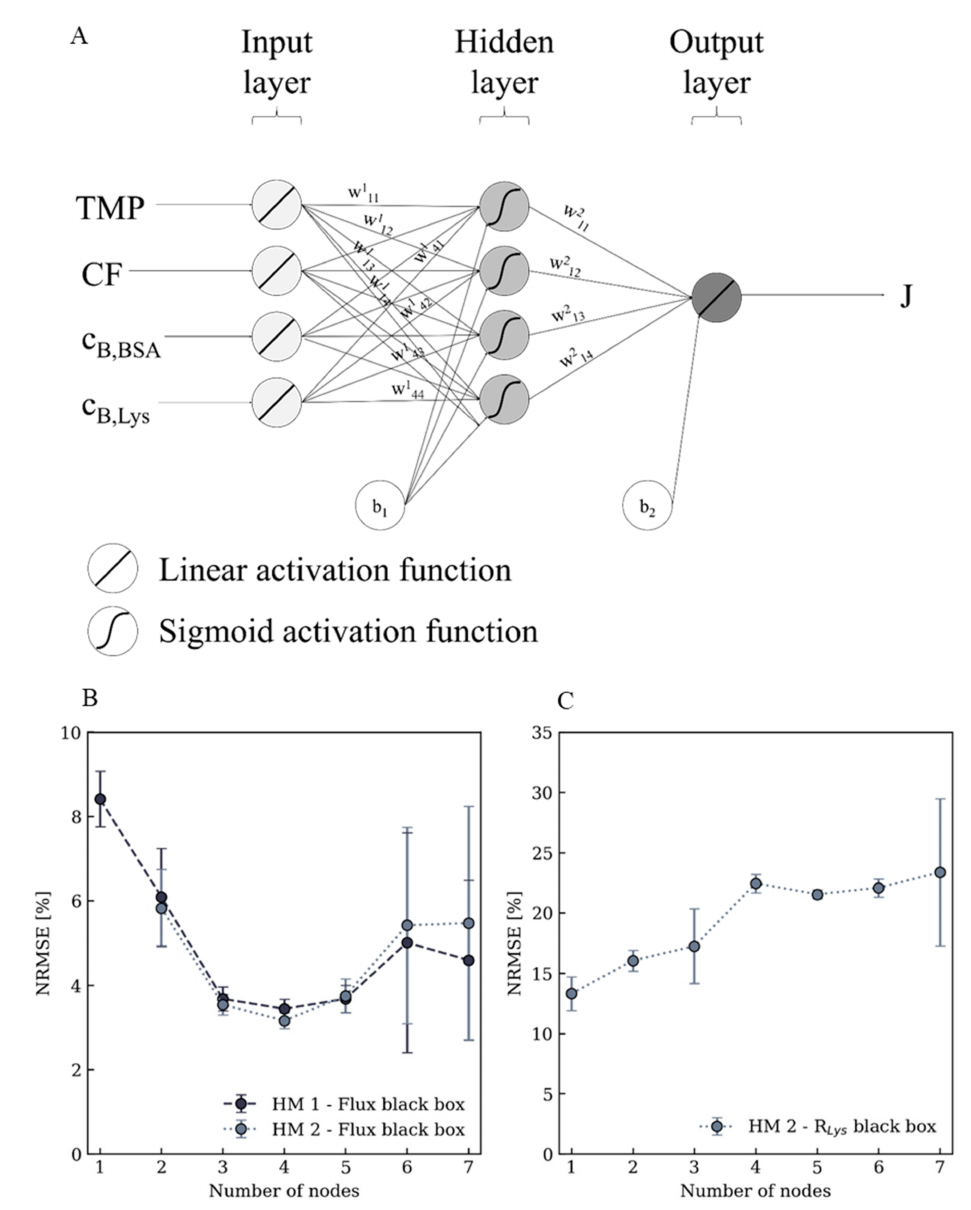
Figure A1. ( A ) Structure of the ANN including input, output and hidden layer, number of hidden nodes and activation functions. ( B , C ) Optimization of the ANN structure. ( B ) The NRMSE is plotted over the number of neurons in the hidden layer of the ANN of the permeate flux predicting black box. (C) The NRMSE of the R Lys black box HM